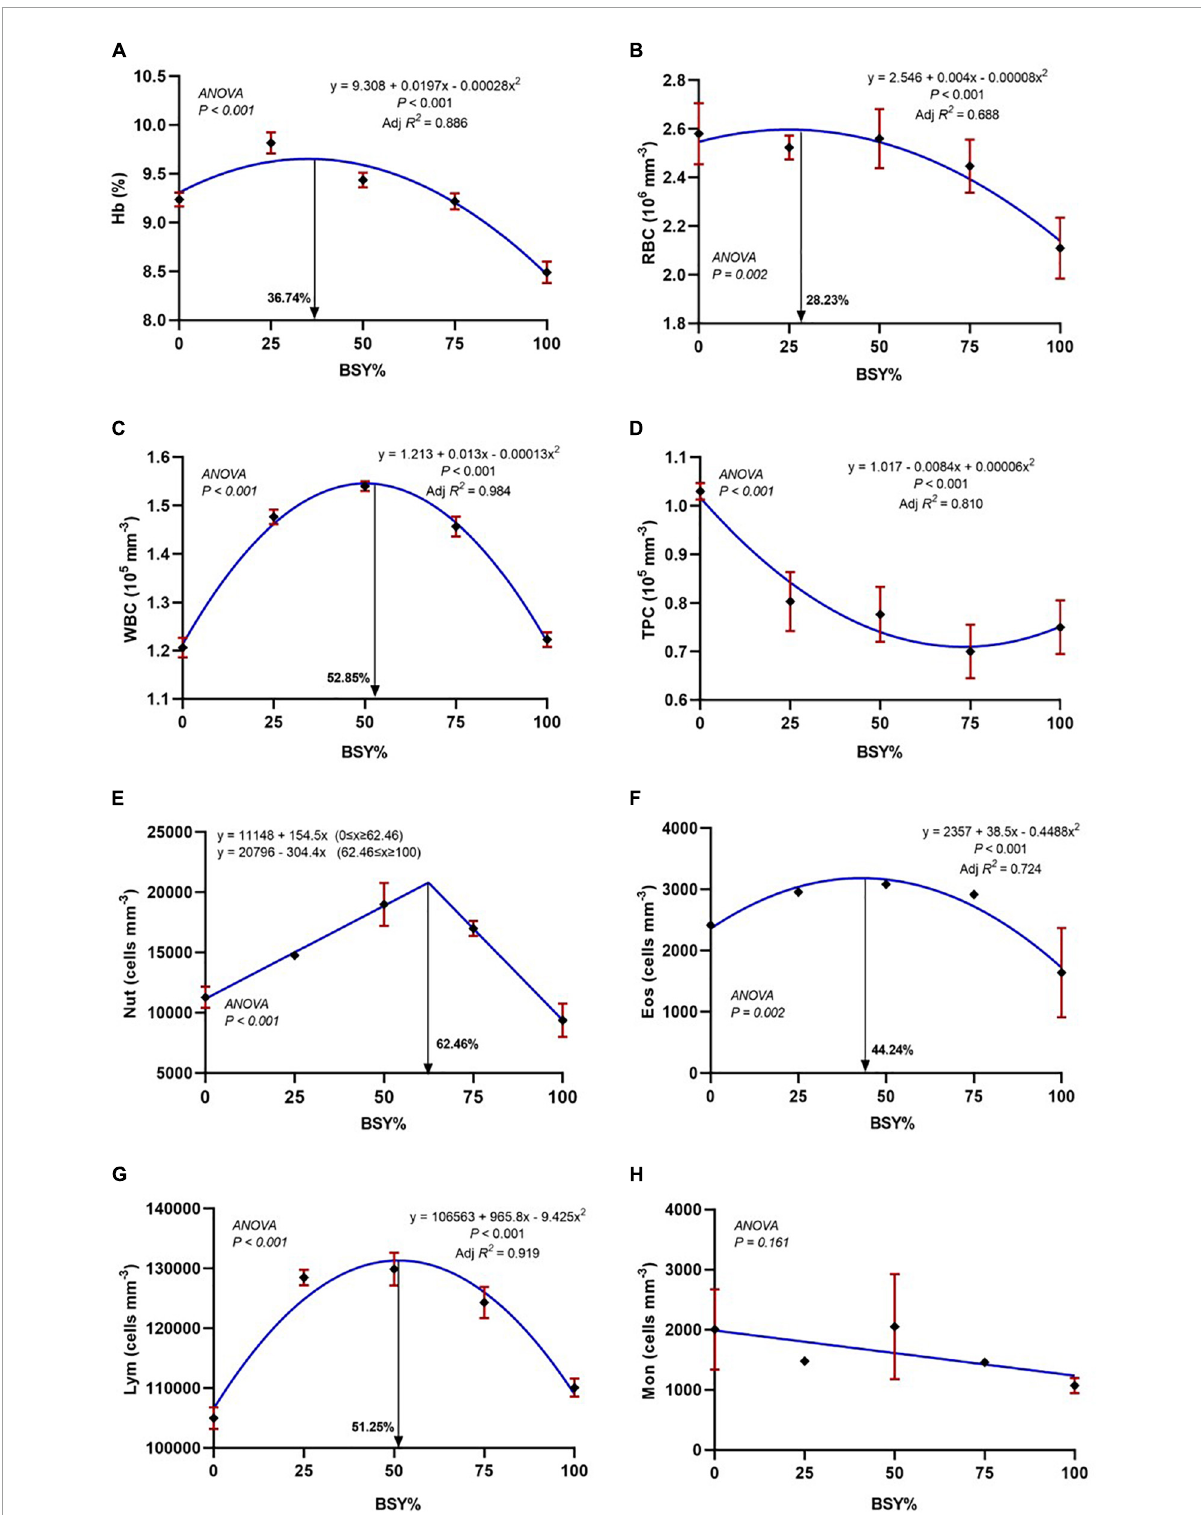
FIGURE6 Hematological responses of climbing perch fingerlings fed with BSY incorporated diet for 60 days. The X-axis represents the gradient inclusion levels of BSY in the place of fishmeal. (A) Hb, Hemoglobin (%); (B) RBC, Red blood cell count (10 6 mm − 3 ); (C) WBC, White blood cell count (10 5 mm − 3 ); (D) TPC, Total platelets count (10 5 mm − 3 ); (E) Nut, Neutrophils (cells mm − 3 ); (F) Eos, Eosinophils (cells mm − 3 ); (G) Lym, Lymphocytes (cells mm − 3 ) and (H) Mon, Monocytes (cells mm − 3 ). The values are expressed as Mean ± SD, n =